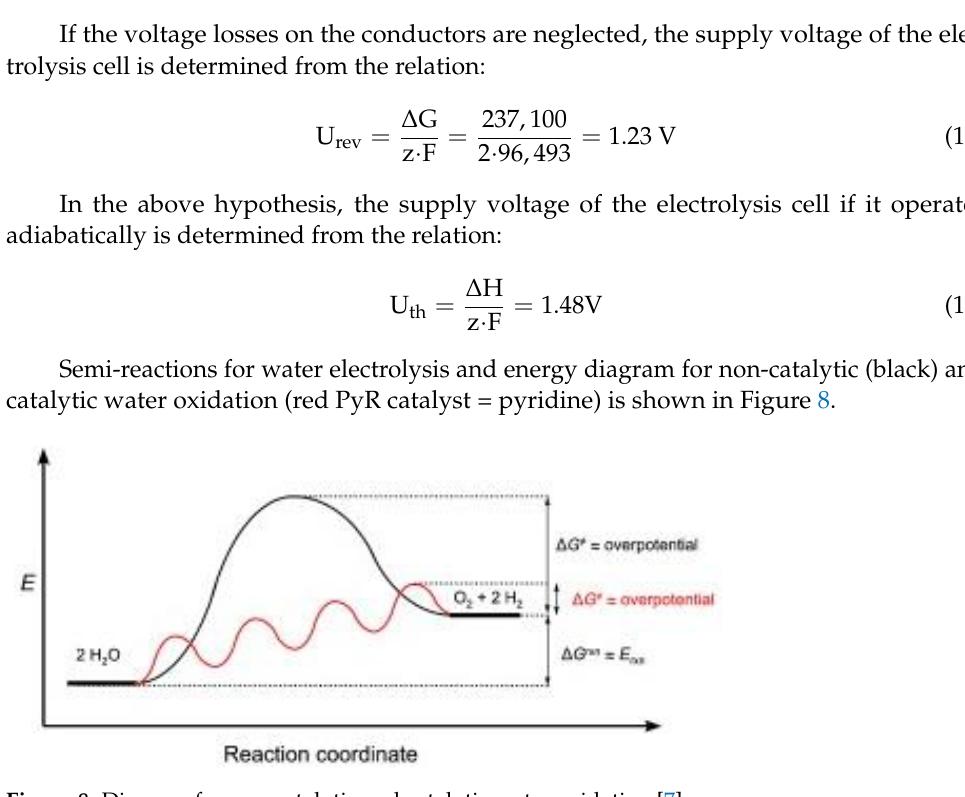
Figure 8. Diagram for non-catalytic and catalytic water oxidation [7].